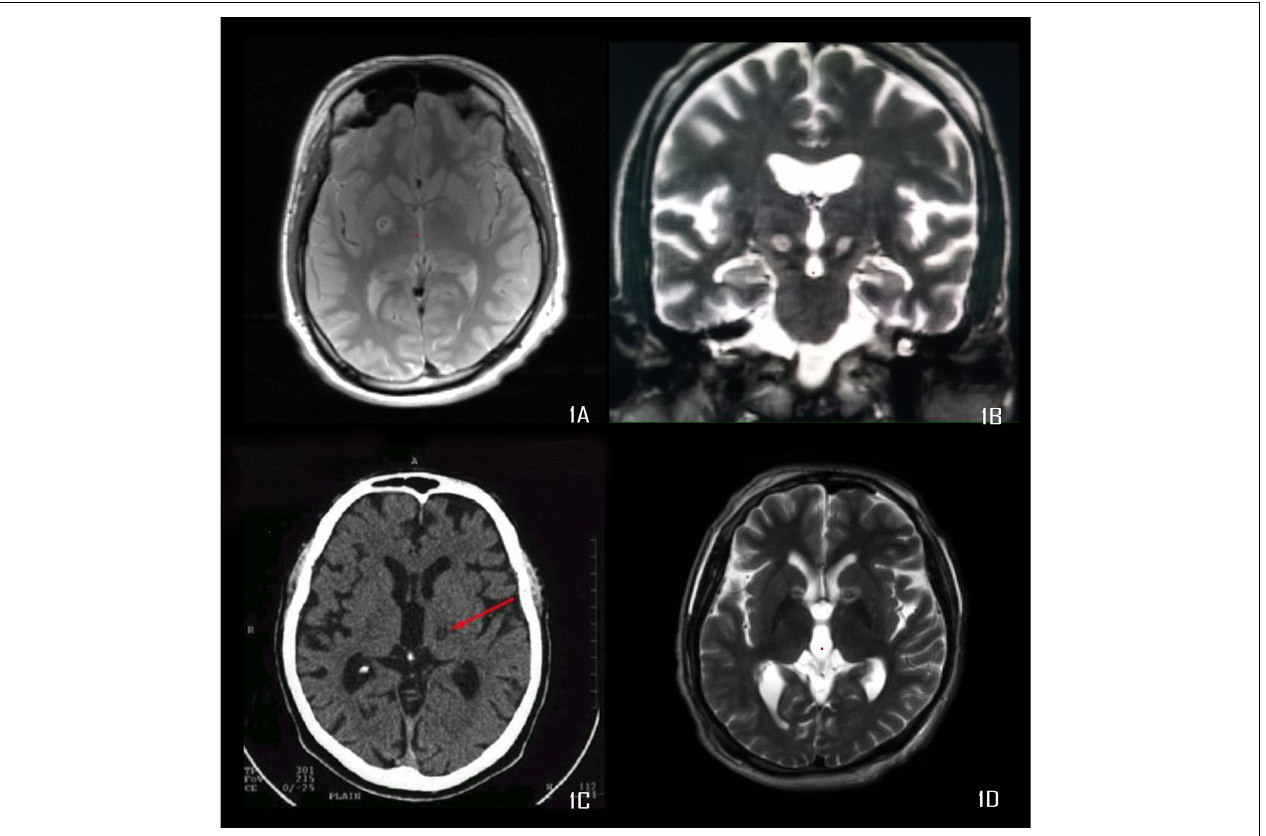
FIGURE 1 | (A) Proton density image showing right pallidotomy, (B) T2 weighted MRI showing bilateral subthalamotomy, (C) CT scan showing Vim thalamotomy, (D) T2 weighted MRI showing bilateral anterior